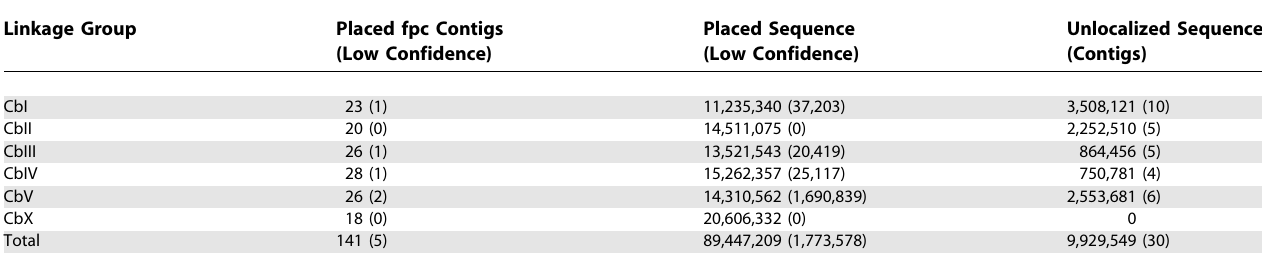
Table 3. Integration with Sequence Map Linkage Group Placed fpc Contigs